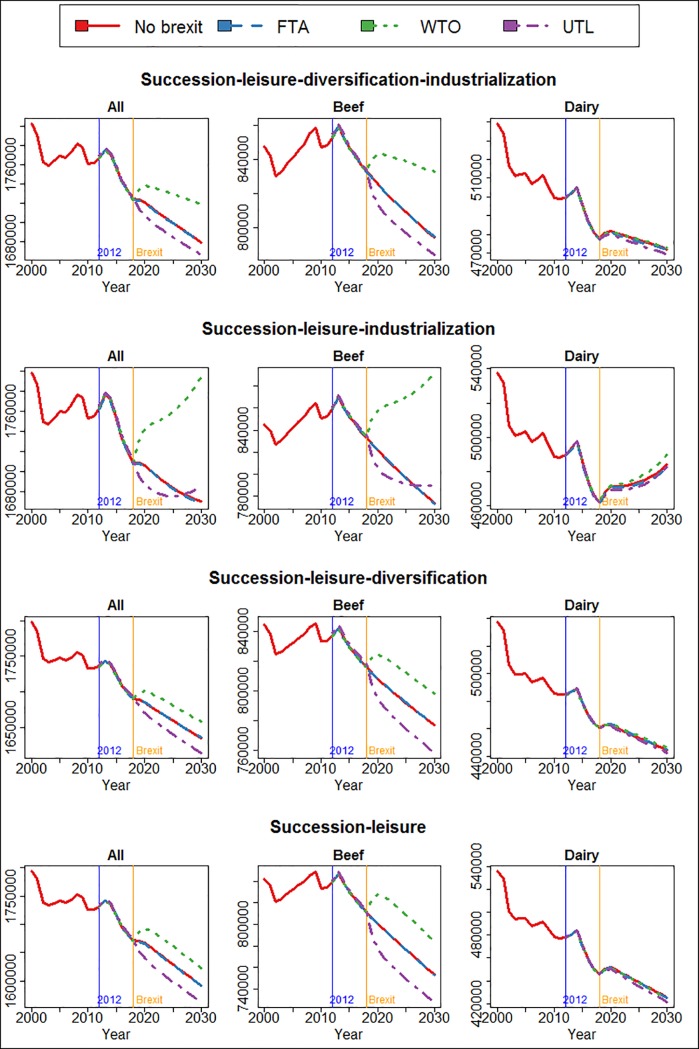
The number of all, beef and dairy cattle in the four Brexit scenarios predicted by the four models selected from POM.